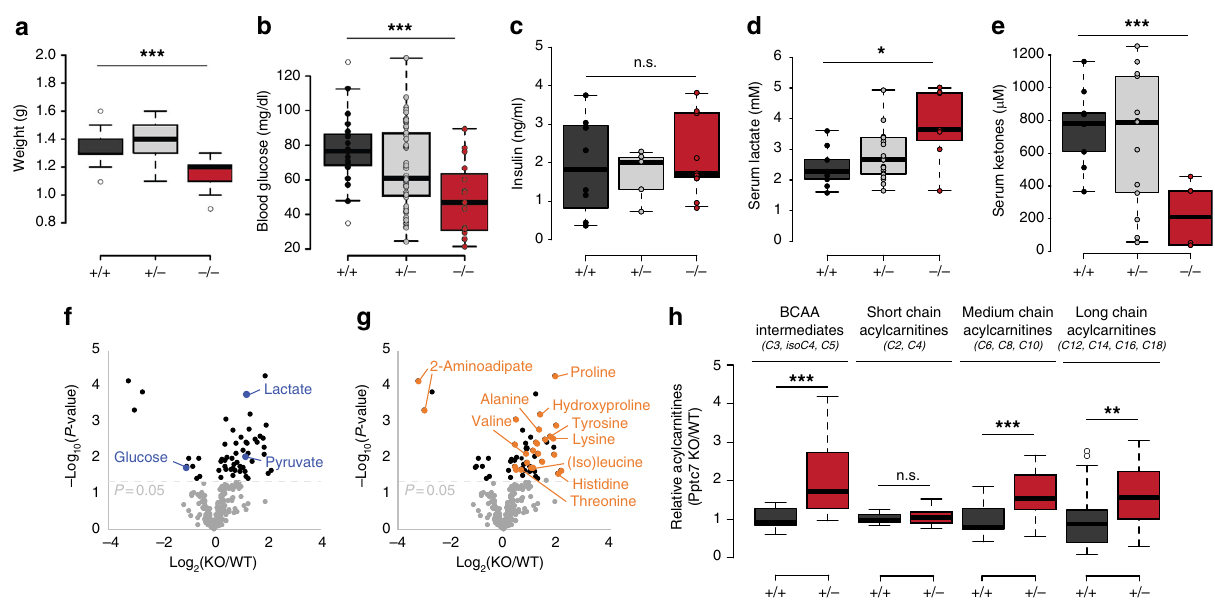
Fig. 2 Pptc7 -null mice have defects associated with inborn errors of metabolism. a Pptc7 KO perinatal pups (P0, red, n = 24) weigh signi fi cantly less than wild type (dark gray, n = 25) and heterozygous (light gray, n = 60) littermates. b Pptc7 KO pups ( n = 15) are hypoglycemic relative to WT ( n = 19) and heterozygous ( n = 52) littermates c Pptc7 KO pups ( n = 10) show no difference in circulating insulin relative to WT ( n = 8) and heterozygous ( n = 5) littermates. d Pptc7 KO pups ( n = 7) have elevated serum lactate relative to WT ( n = 9) and heterozygous ( n = 22) littermates. e Pptc7 KO pups ( n = 6) have lower concentrations of serum ketones relative to WT ( n = 9) and heterozygous ( n = 13) pups. f Metabolomics data from liver tissues reveal decreased glucose and increased lactate and pyruvate in KO ( n = 5) samples relative to WT ( n = 5). g Metabolomics data from liver tissue (same data as shown in f ) reveal numerous differences in amino acids and their intermediates in KO samples relative to WT. h Acylcarnitine analysis of liver tissues from KO and WT. For each plot, n = 7 tissues per genotype for each reported acylcarnitine species. For box plots in a – e and h , center lines show the medians; box limits indicate the 25th and 75th percentiles as determined by R software; whiskers extend 1.5 times the interquartile range from the 25th to 75th percentiles, and outliers are represented by white dots. Signi fi cance calculated by a two-tailed Student ’ s t -test; * = p < 0.05, ** = p < 0.01, *** = p < 0.001, n.s. = not signi fi cant ( p > 0.05). Source data for panels f , g , and h are provided as a Source Data fi